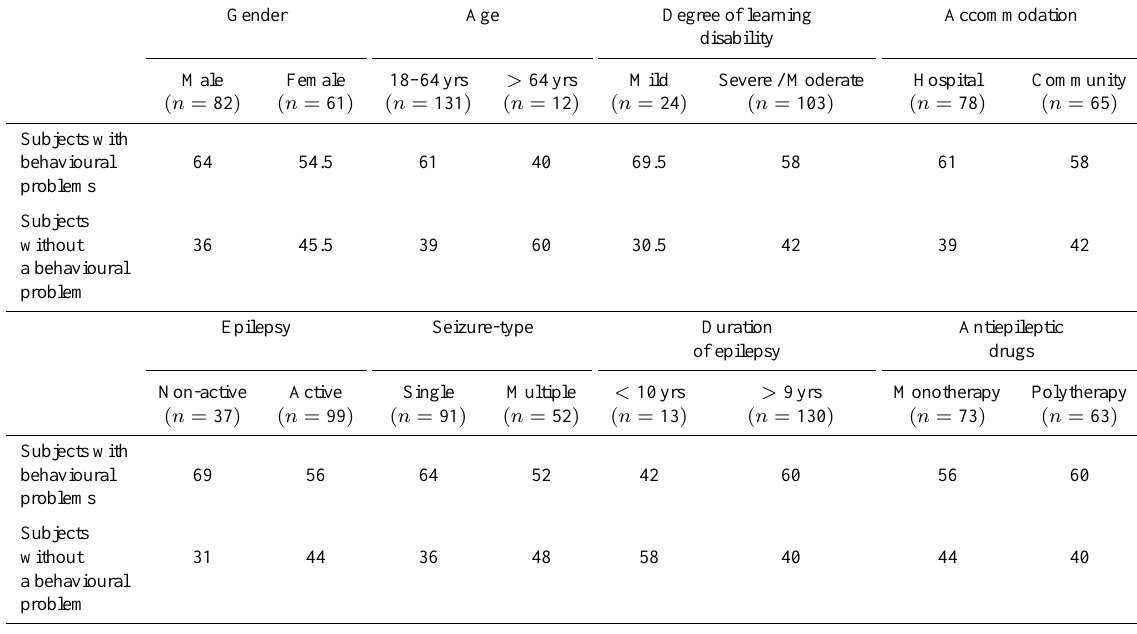
Table 1 Percentage of subjects with or without behavioural problems in different subgroups of the cohort